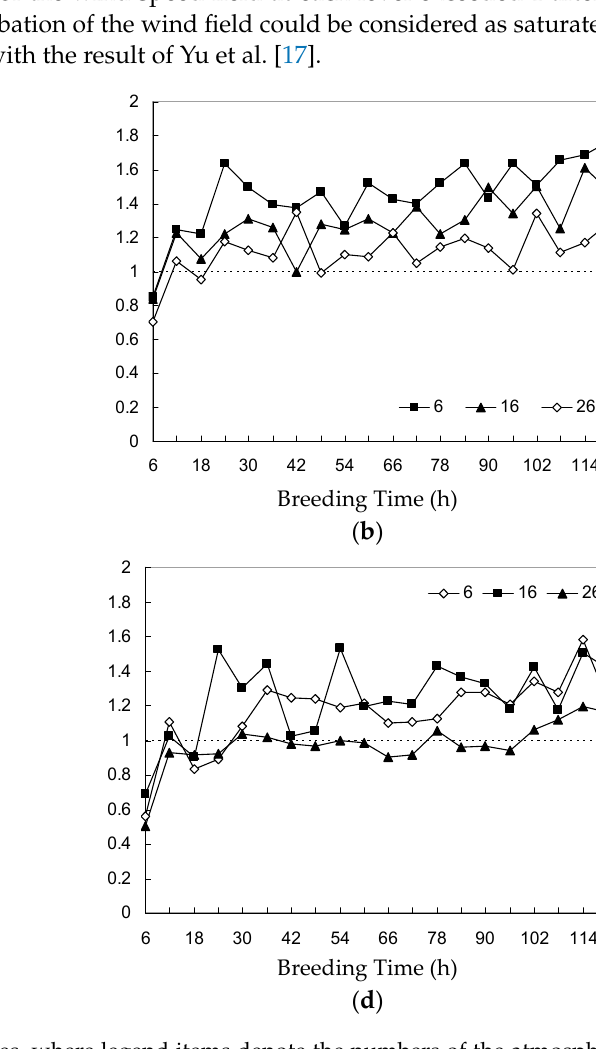
Figure 4. Growth rate of perturbed atmospheric variables, where legend items denote the numbers of the atmospheric model levels. ( a ) Zonal wind speed ( u ), ( b ) meridional wind speed ( v ), ( c ) air temperature ( T ), ( d ) specific humidity ( q v ).